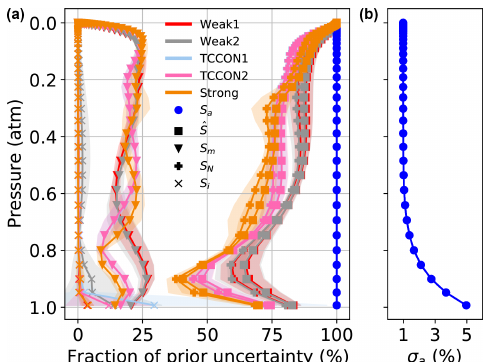
Figure D8. Panel (a) shows the square root of the diagonal elements of the retrieval total error covariance matrix ˆ S , the null space covari- ance matrix S N , the interference error covariance matrix S i , and the measurement noise error covariance matrix S m expressed as a frac- tion of the a priori uncertainty σ a . Each line is the average from the set of 8 days with AirCore measurements over Lamont, and the bands indicate the standard deviation. Panel (b) shows the a priori uncertainty.